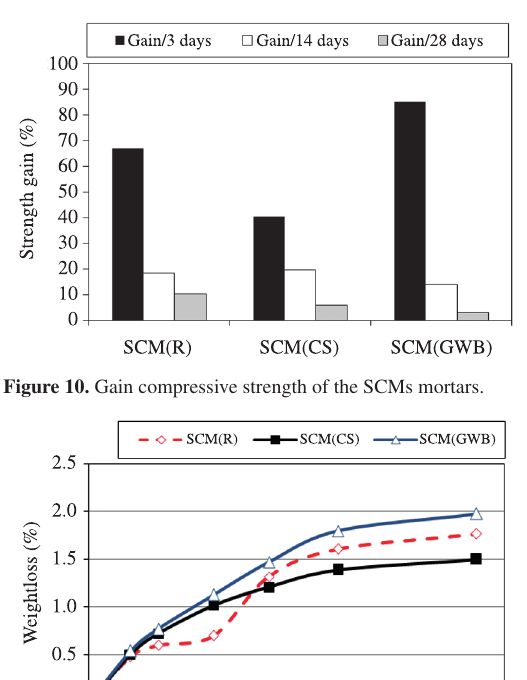
Figure 9. Comparison of treated and untreated mortars thermally; compressive strength of the SCMs mortars at 14 and 28 days.